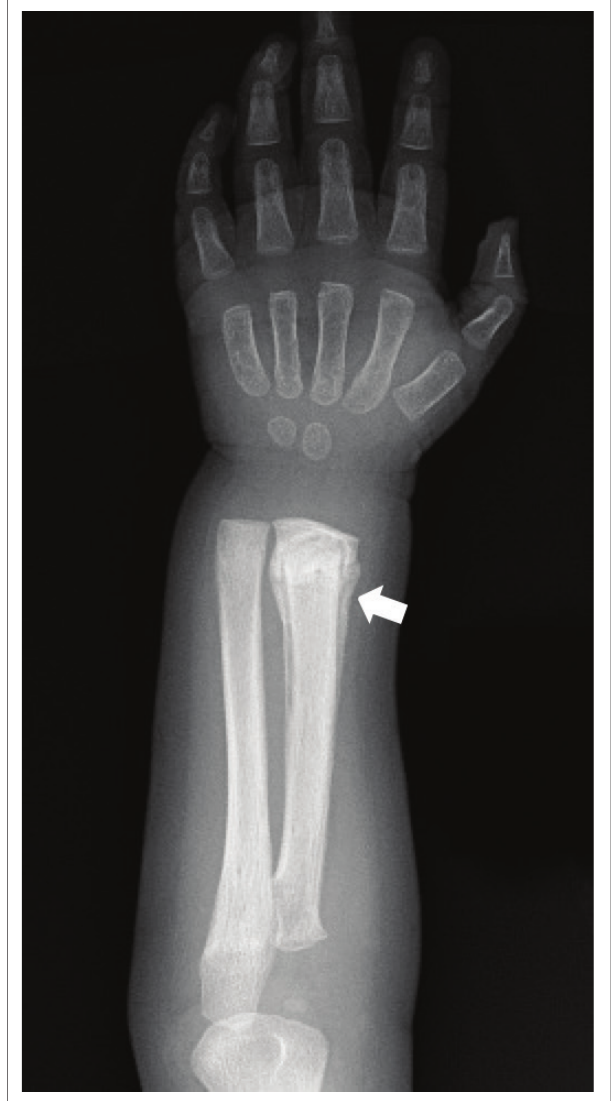
FIGURE 5: Five-year-old-male with a distal radial diaphyseal fracture with callus formation (white arrow) indicating a healing fracture on an AP view of the right forearm. This is a low-specificity fracture for non-accidental injury.